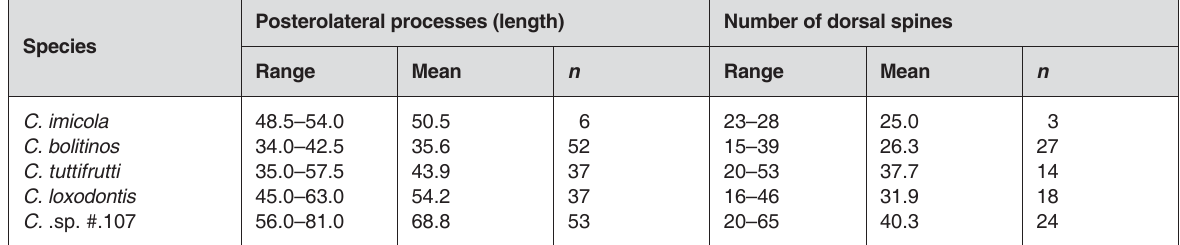
TABLE 4 Lengths ( μ m) of posterolateral processes and number of dorsal spinules on the caudal segment of the pupae of five species of Culicoides of the Imicola complex